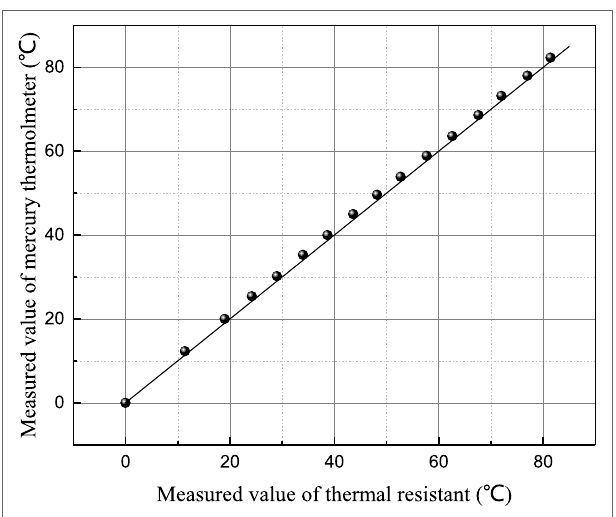
FigUre 3 | The history of measured surface tension of sodium thiosulfate by platinum plate method (sodium thiosulfate concentration is 1 mol/L; solution temperature is